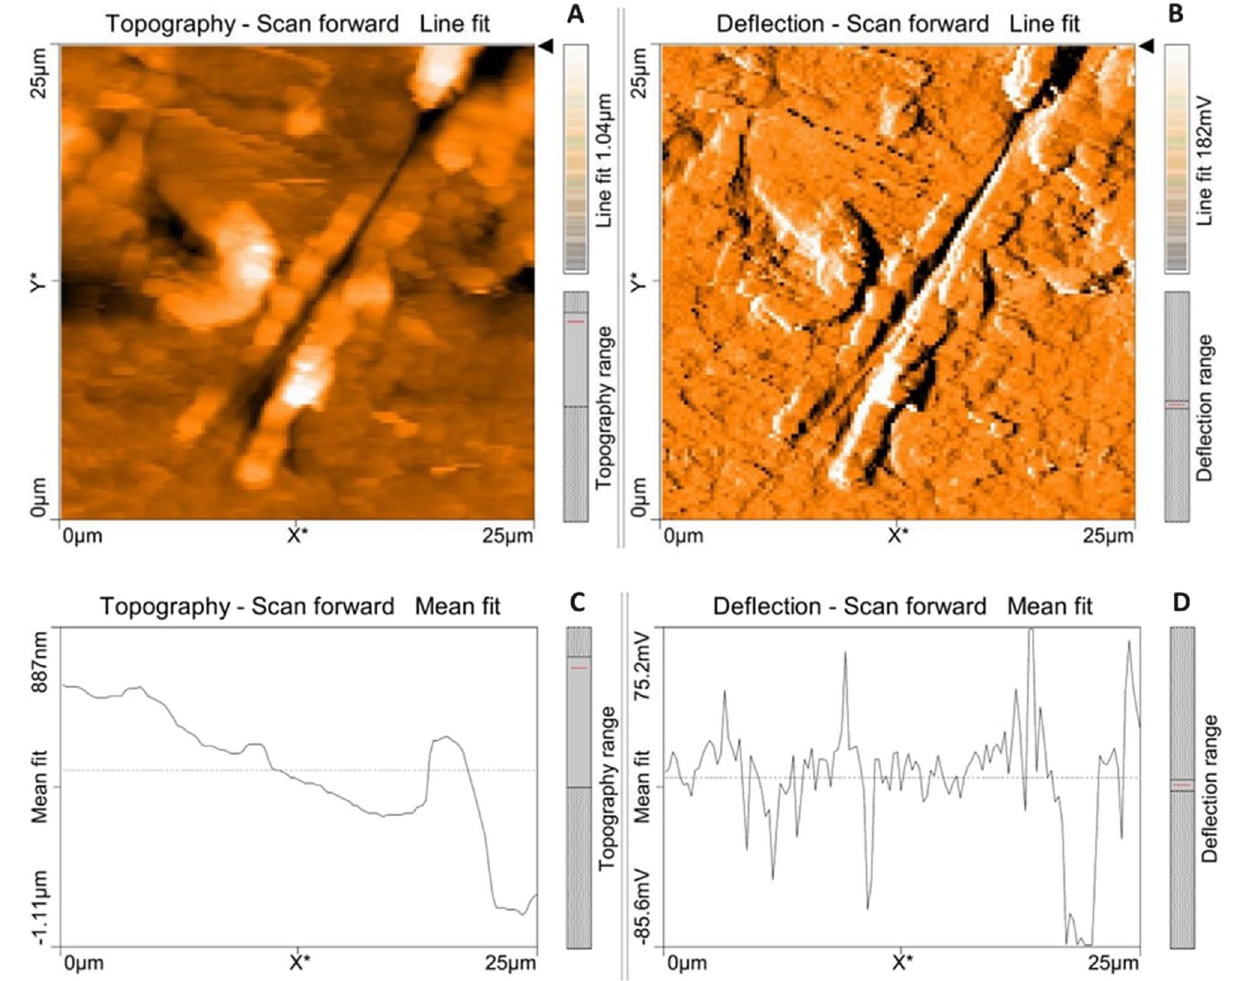
Figure 23. Atomic force microscopic results of microalga U. africanum treated LDPE sheet of 25 µm 2 area: ( A ) Topography of the surface (Line fit); ( B ) Voltage deflection (Line fit); ( C ) Topography with mean fit; and ( D ) Voltage deflection with mean